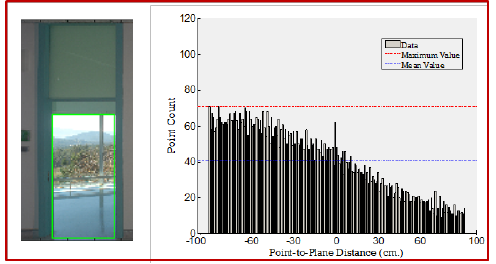
Figure 7. Histogram of point-to-plane distances: Open door